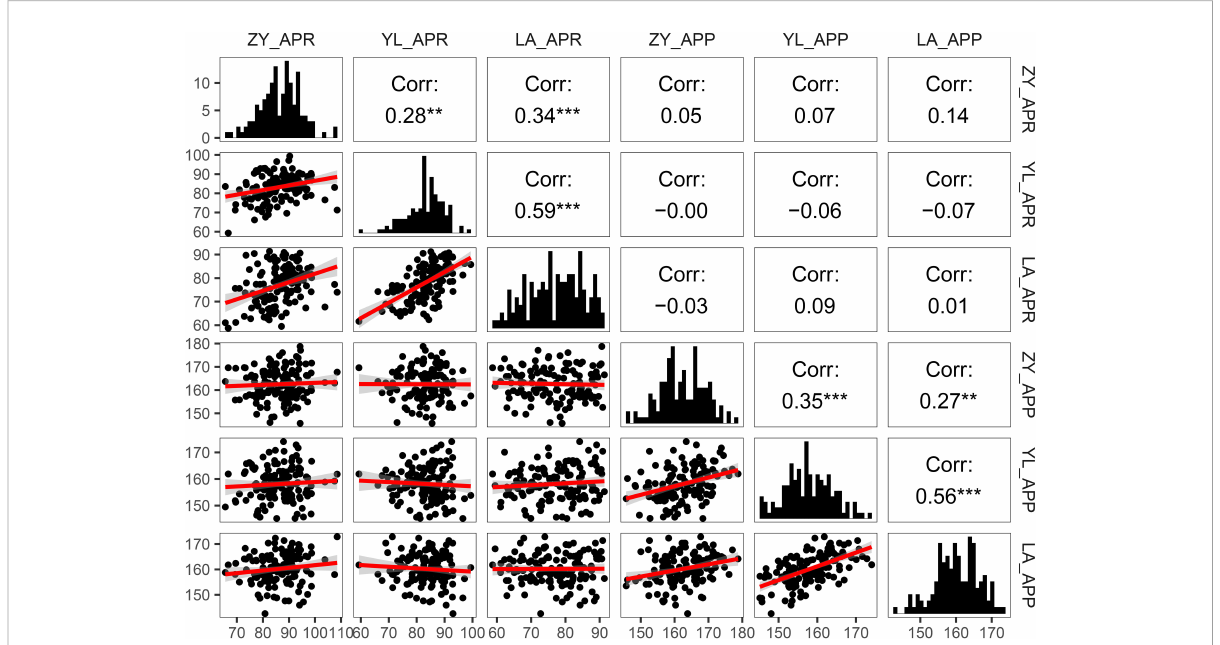
FIGURE 2 Pearson correlations and frequency distribution for pod orientation traits (Angle of the pedicle to raceme: APR and angle of the pod to pedicel: APP) among 136 rapeseed accession grown across three environments (ZY: Zunyi, YL: Yangluo, LA: Lu ’ an). The lower left part of the picture is the scatter diagram among the environments; the red line shows simple linear regression of variables. The diagonal corner is the frequency distribution diagram of the environments. The upper right corner is the correlation between the environments. **: P<0.01 indicates highly signi fi cant correlation; ***: P<0.001 indicates extremely signi fi cant